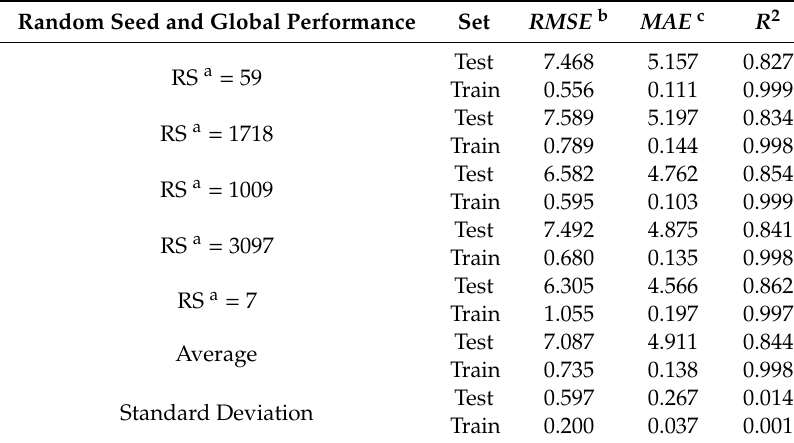
Table 11. Measured performance of Gaussian process